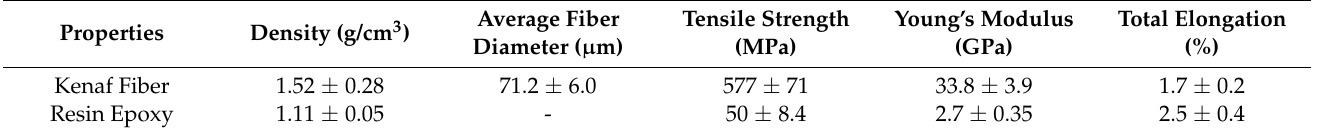
Properties Table 1. Properties of the as-supplied kenaf fibers and the DGEBA/TETA epoxy.